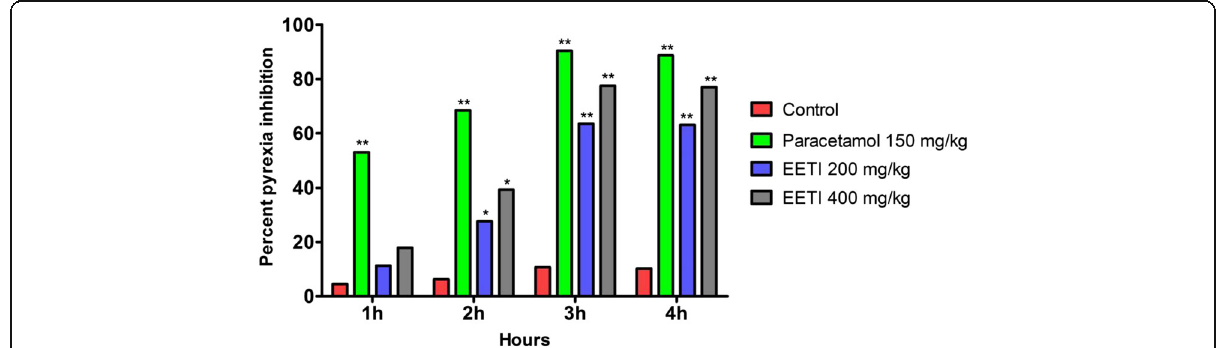
Fig. 2 Antipyretic effect of EETI in mice. Bar presents the percent inhibition of pyrexia after 1, 2, 3 and 4 h of the treatment with Paracetamol (150 mg/kg) and EETI (200 and 400 mg/kg). * p < 0.05 , ** p < 0.01 , significantly different in comparison with control. The data was analyzed by ANOVA followed by Dunnett ’ s